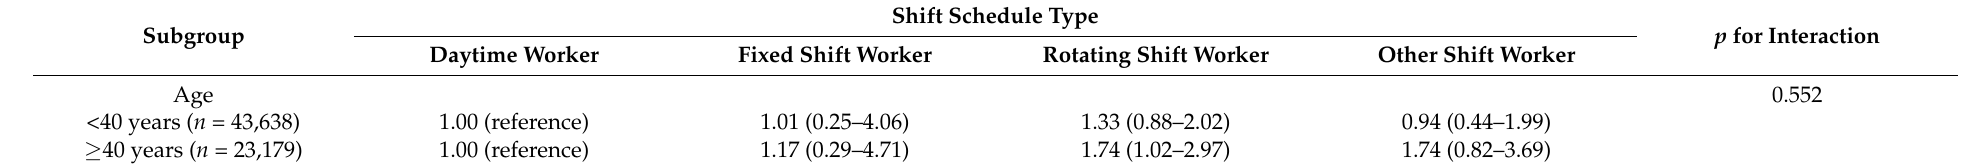
Table 4. Hazard ratios (95% CI) a for elevated PSA by shift schedule type subgrouped by